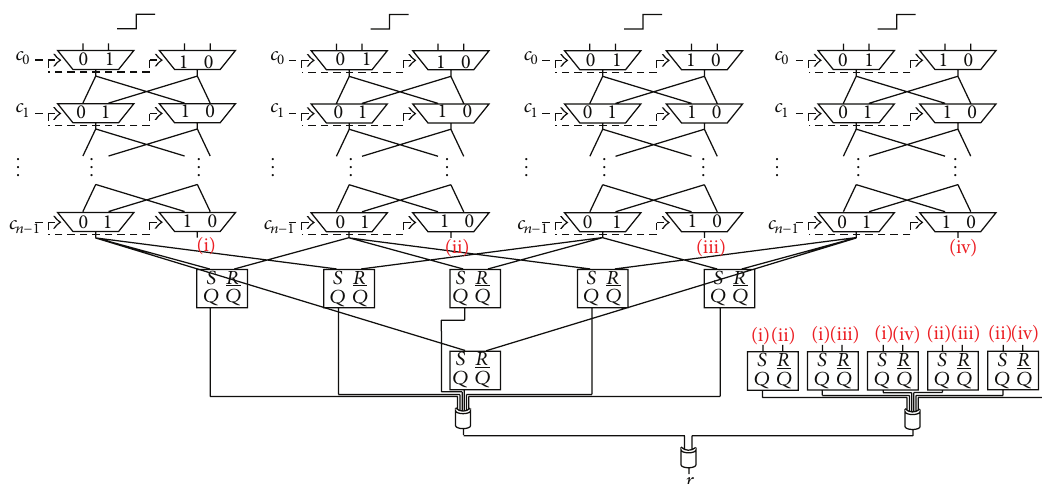
Figure 13: Structure of the 4-1 Double Arbiter